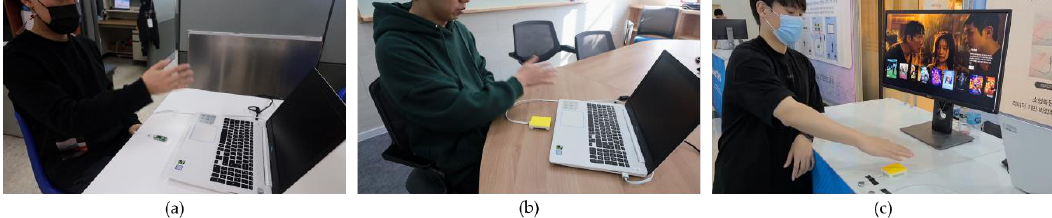
Figure 14. Examples of various experimental environments: ( a ) office for collecting source domain data; ( b ) lecture room for collecting target domain data; ( c ) exhibition hall for real-time experiment.